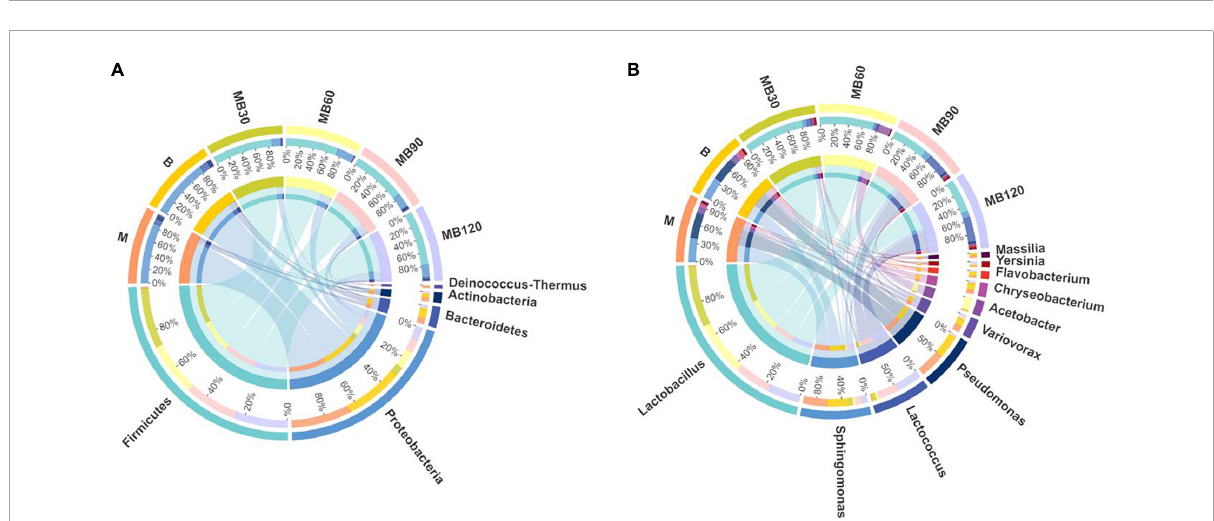
FIGURE3 Circos map of bacterial communities at the phylum (A) and genus levels (B) for fresh materials and ensiling. M, maize; B, faba bean; MB30, 30 days of mixed silage of maize and faba bean; MB60, 60 days of mixed silage of maize and faba bean; MB90, 90 days of mixed silage of maize and faba bean; MB120, 120 days of mixed silage of maize and faba